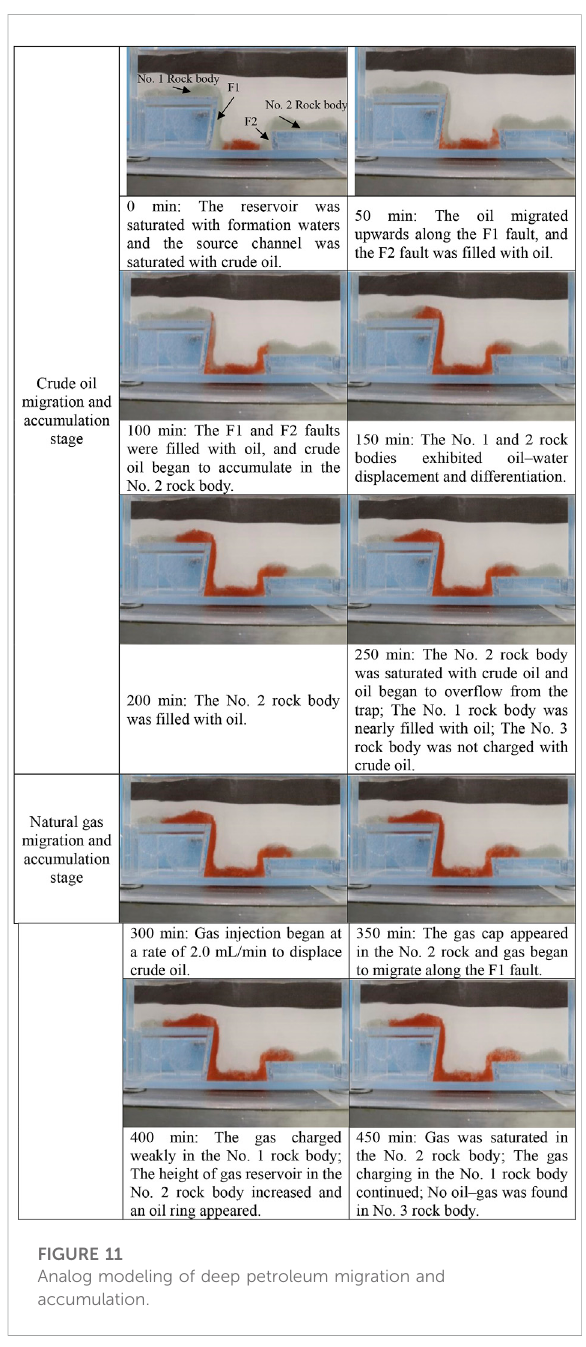
FIGURE 11 Analog modeling of deep petroleum migration and